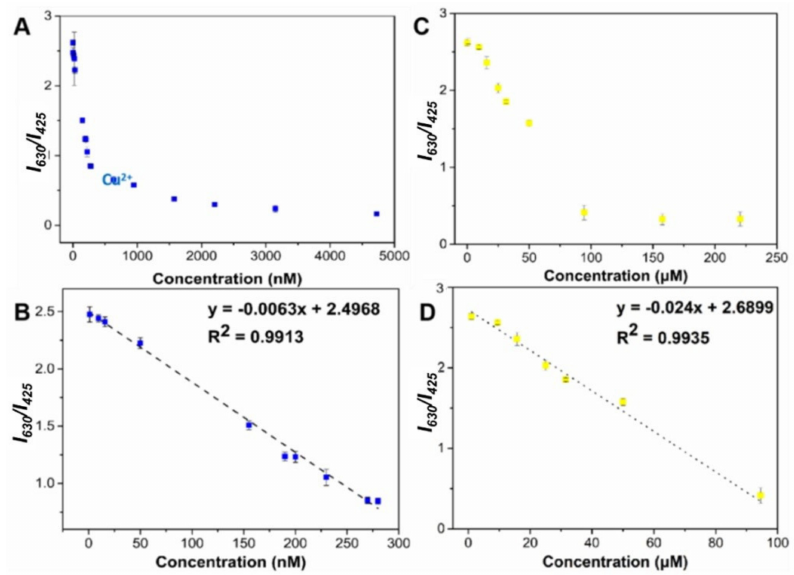
Figure 6. The fluorescence emission ratio spectra of CQDs/QDs@ZIF − 67 in the presence of dif- ferent concentrations of Cu 2+ ( A ) and Pb 2+ ( C ); linear relationships of the emission intensity of